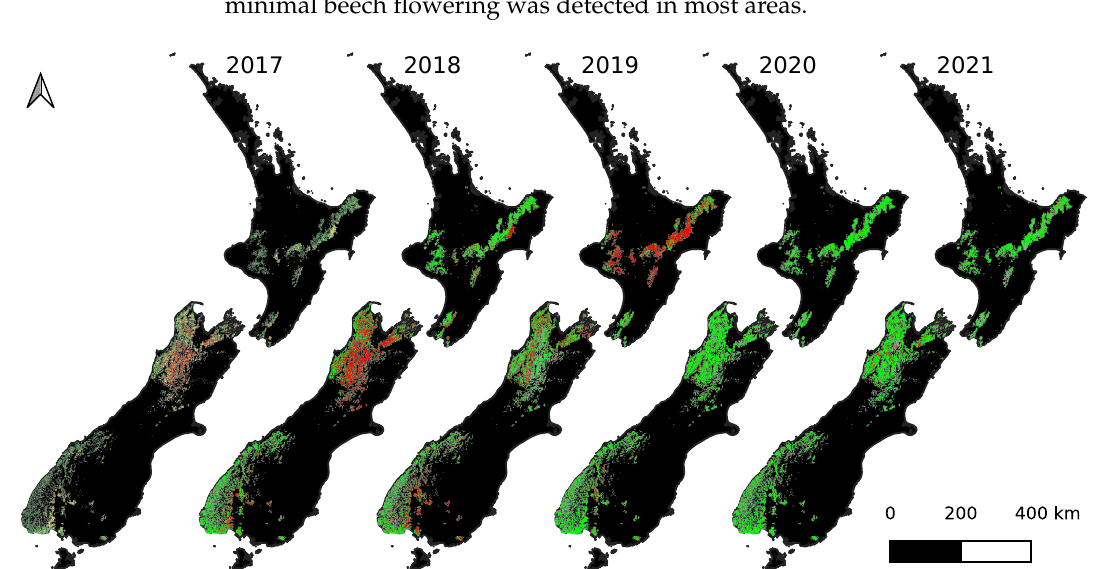
Figure 4. The maps of heavy beech flowering during spring time for four years using Sentinel-2 imagery (2017–2021 inclusive). The classes are “heavy flowering detected” (red), “heavy flowering not detected” (green), and “no cloud-free imagery”